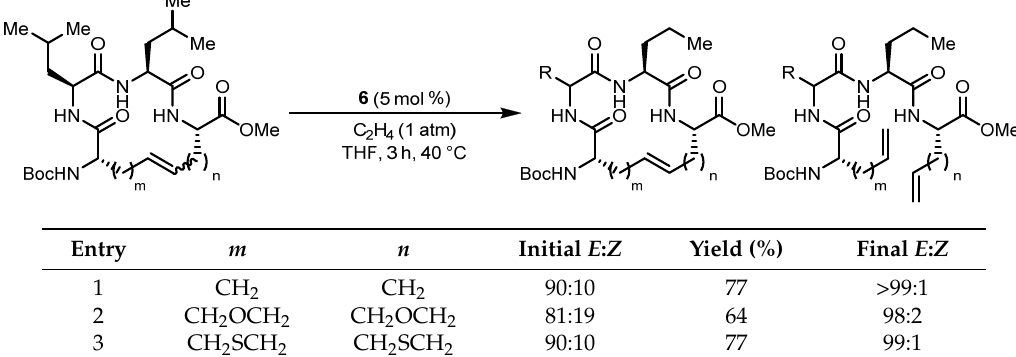
Table 21. Z -selective ethenolysis to furnish high E macrocyclic peptides.